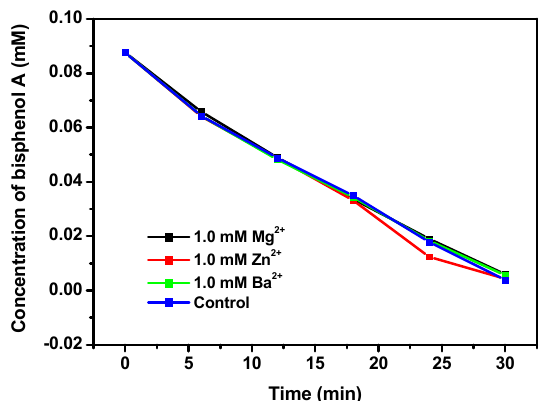
Figure 9. The effect of different cations on the degradation efficiency of bisphenol A with Ag 3 PO 4 and potassium persulfate as photocatalysts under visible light irradiation.